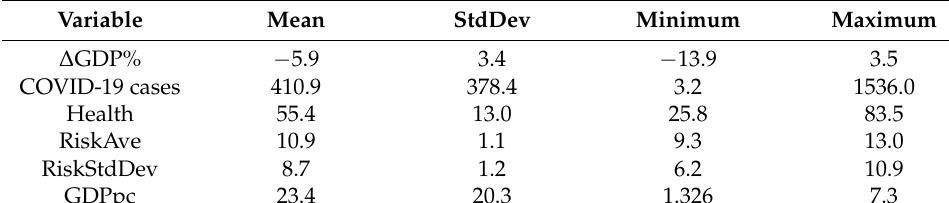
Table 3. Descriptive statistics of the indicated variable with COVID-19 economic data.